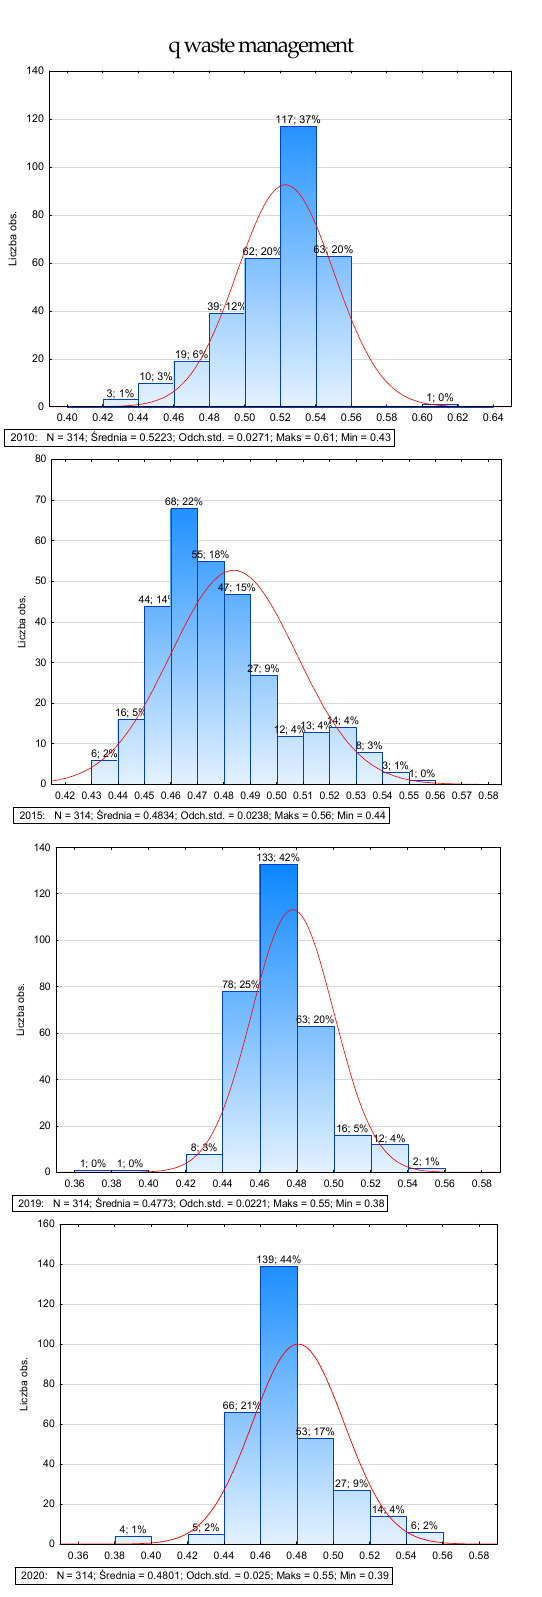
Figure 4. Distribution diagram of the synthetic measure, waste management and green economy in districts in Poland (in 2010, 2015, 2019, and 2020). Source: Own study. Scatterplot analysis shows what kind of relationship we are dealing with (positive or negative). This allows for the indication of groups of objects with similar values of the examined criterion, the indication of outliers (statistically distinct), and the indication of regularity (or irregularities) in the data set. The Pearson correlation coefficient between the value of the synthetic measure in the year-on-year report is shown in Figure 5. Higher correlation indicators in the year-on-year report are observed in the case of the green econ- omy measure (the ratio of 2010 to 2015 and is 0.670; the ratio of 2020 to 2019 and is 0.937), lower for waste management (the ratio of 2010 to 2015 and is 0.301; the ratio of 2020 to 2019 and is 0.803). q waste management q green economy y = 0.1362 + 0.7105*x; r = 0.8032; p = 0.0000; r2 = 0.6452 0.38 0.40 0.42 0.44 0.46 0.48 0.50 0.52 0.54 0.56 0.58 20200.360.380.400.420.440.46 0.480.500.520.540.56 0.58 201 9